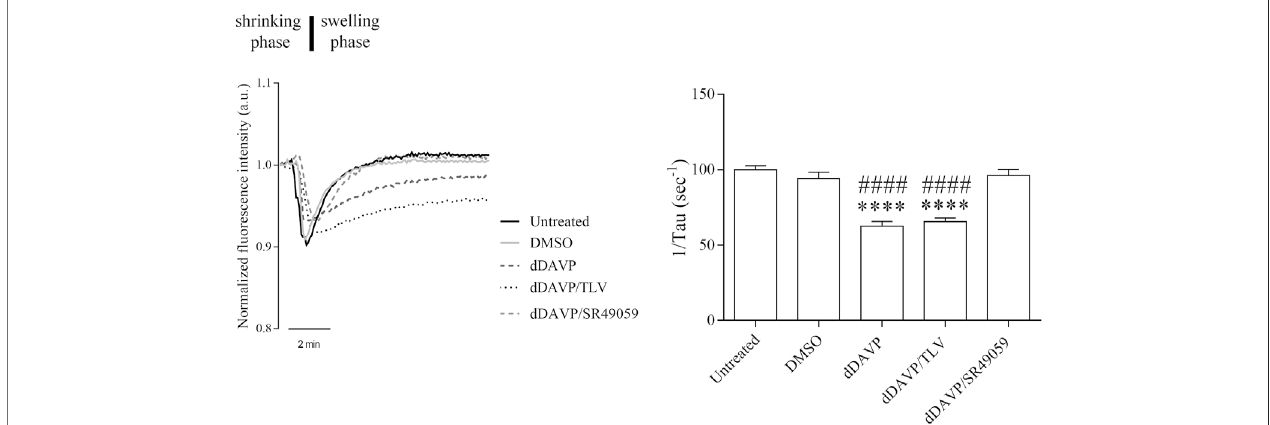
FIGURE 6 | Effect of Vasopressin receptors on glycerol permeability. Osmotically induced volume changes recorded by the calcein-quenching method in HCT8 cells exposed to dDAVP stimulation or cotreated with V1aR antagonist (dDAVP/TLV) or VR2 antagonist (dDAVP/SR49059) compared to control conditions (untreated, DMSO). On the left, a representative time course of cell shrinking (water exit) followed by cell swelling indicative of the osmotic in fl ux of water promoted by glycerol entry alongitsgradient( Δ 100 mOsm/L).Ontheright,abarplotshowingthemean±S.E.M.valuesofthecellswellingtimeconstants(1/ τ ,s -1 )re fl ectingglycerolentryinto the cells. Note that the treatment with 100 nM dDAVP signi fi cantly reduced glycerol permeability. A comparable effect was observed after cotreatment with 100 nM dDAVPand100 nMtolvaptanfor72 h.Bycontrast,treatmentwith100 nMSR49059for72 hpreventedthedDAVPeffectonglyceroluptake.Dataareobtainedfrom35 to 56different measurementsof3 independent experiments. Aone-way ANOVA and Dunnett ’ sMultiple Comparison test were performed (**** p < 0.0001vs. untreated; #### p < 0.0001 vs. DMSO).